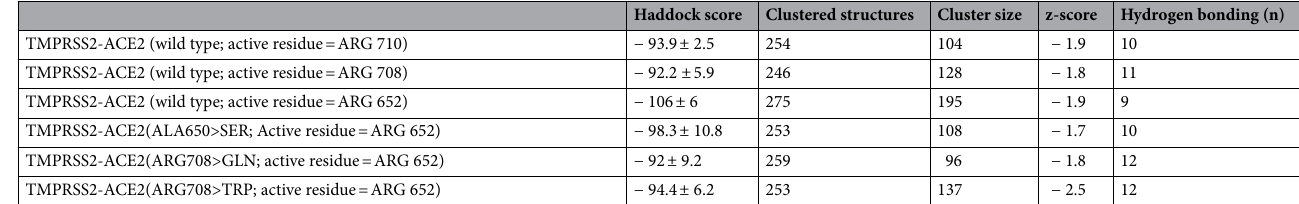
Haddock score Clustered structures Cluster size z-score Hydrogen bonding